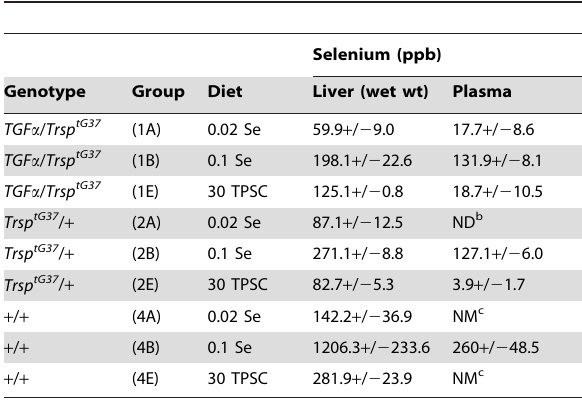
Table 5. Selenium levels in liver and plasma of TGF a /Trsp tG37 , Trsp tG37 / + and + / + mice a